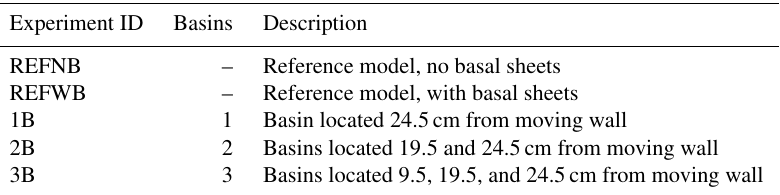
Table 2. List of the performed analogue models.